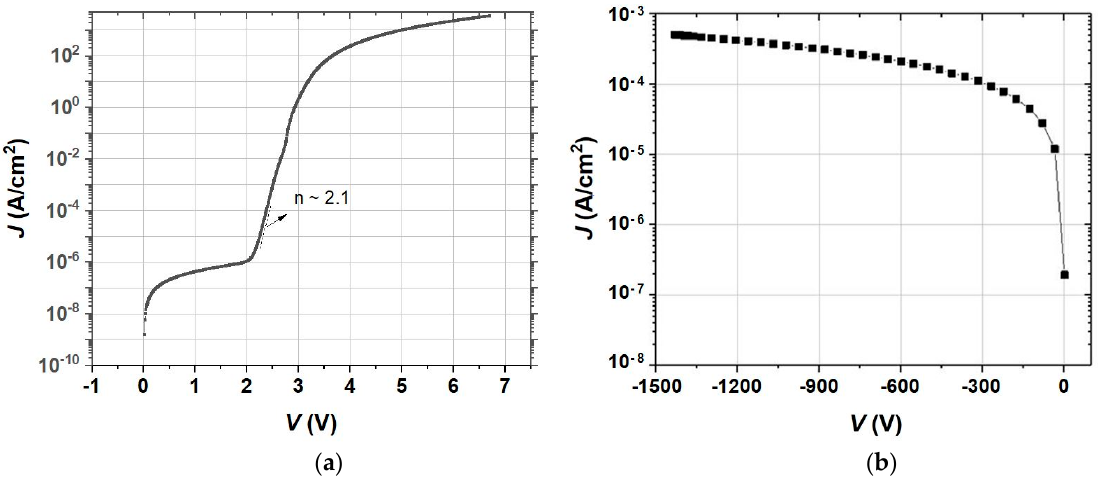
Figure 8. Forward- (a) and reverse- (b) biased I-V characteristics of a 120- µ m diameter PIN diode grown on SixPoint’s NEAT GaN substrate.